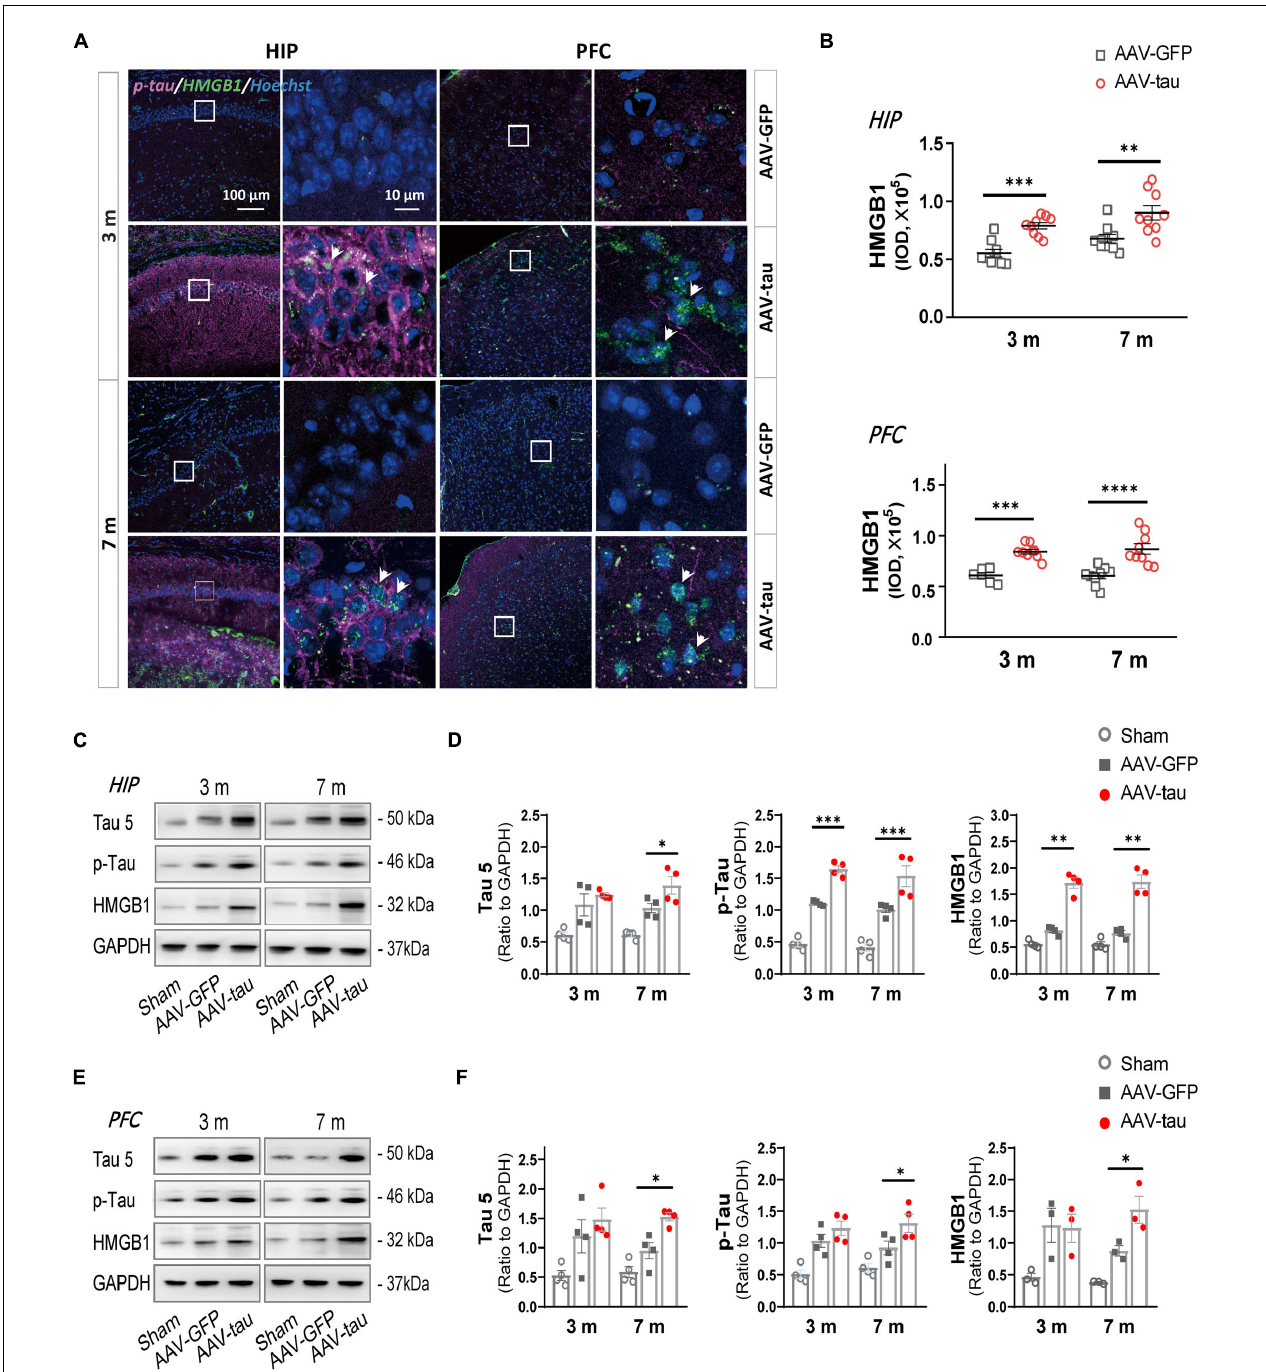
FIGURE 3 | Overexpression of p-tau led to increases in HMGB1 and tau expressions. (A) Representative images of HMGB1 (green) and p-tau (ser404) (purple) in the ipsilateral hippocampus (HIP) and prefrontal cortex (PFC) taken from mice injected with AAV-tau or AAV-GFP 3 and 7 months after injection. Right columns of HIP and PFC are higher magnification sections of the dashed squares in the left columns, and white arrows indicate positive staining for p-tau or HMGB1. (B) Quantification of HMGB1 with fluorescence intensity (nine regions of interest from three mice for every group) showed significant increases in HMGB1 levels in the HIP (top) and PFC (bottom). (C–F) Representative western blots of tau 5 (total tau), p-tau (ser404), and HMGB1 in (C) the ipsilateral hippocampus and (E) PFC. Quantifications by the integrated optical density showed increased immunoreactivities for tau 5 (left), p-tau (middle), and HMGB1 (right) in the (D) HIP and (F) PFC of mice with AAV-tau or AAV-GFP 3 and 7 months after virus injection, and data were normalized to glyceraldehyde 3-phosphate dehydrogenase (GAPDH), n = 3–4 per group. Two-way ANOVA was performed followed by Bonferroni’s multiple comparisons test for behavioral analysis, ∗ p < 0.05, ∗∗ p < 0.01, ∗∗∗ p < 0.001, ∗∗∗∗ p <